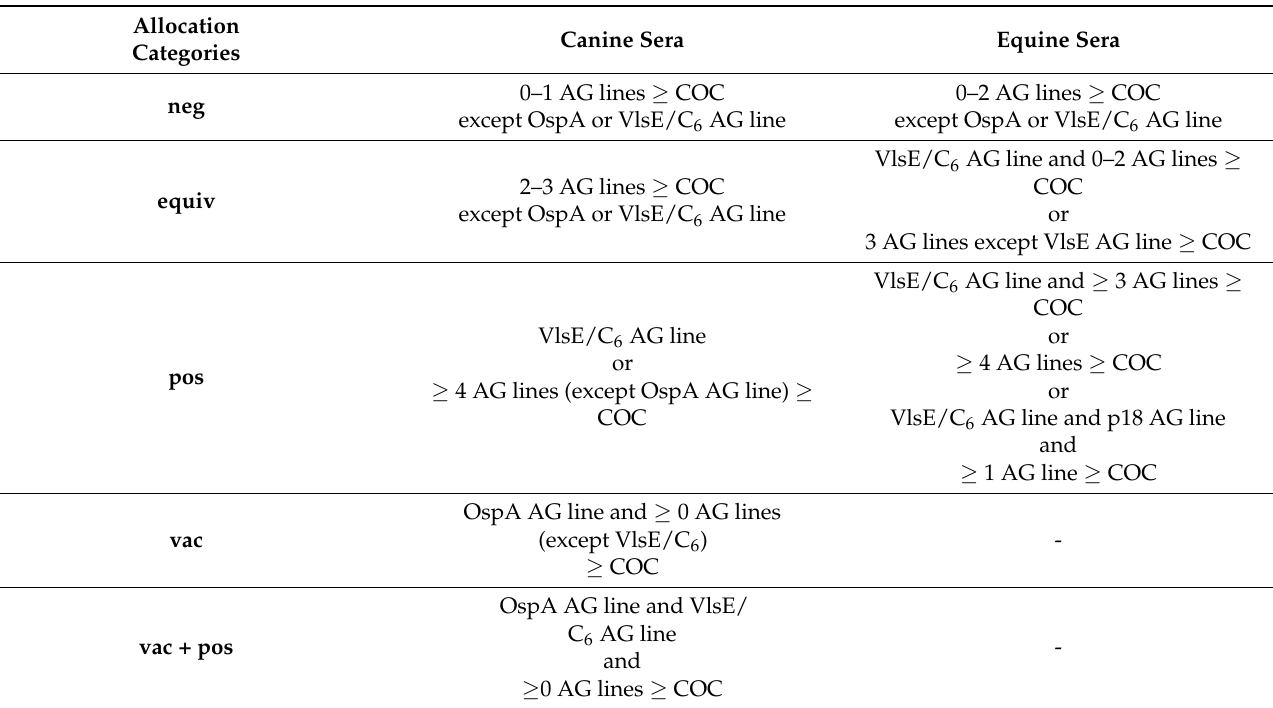
Table 3. Allocation of serum samples based on results obtained with LIA A and to its manufacturer’s